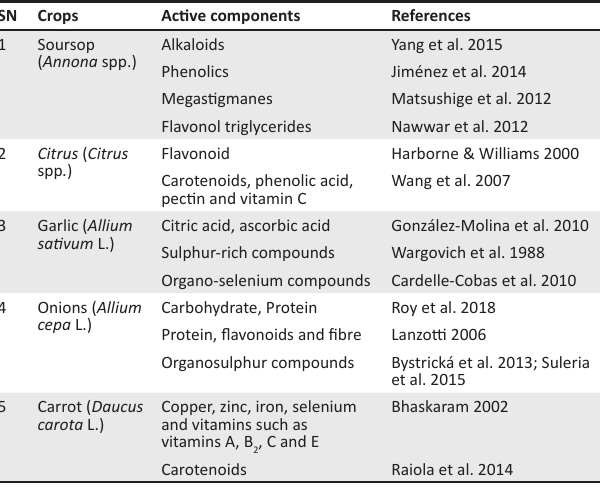
TABLE 1: Summary of some horticultural crops and their active